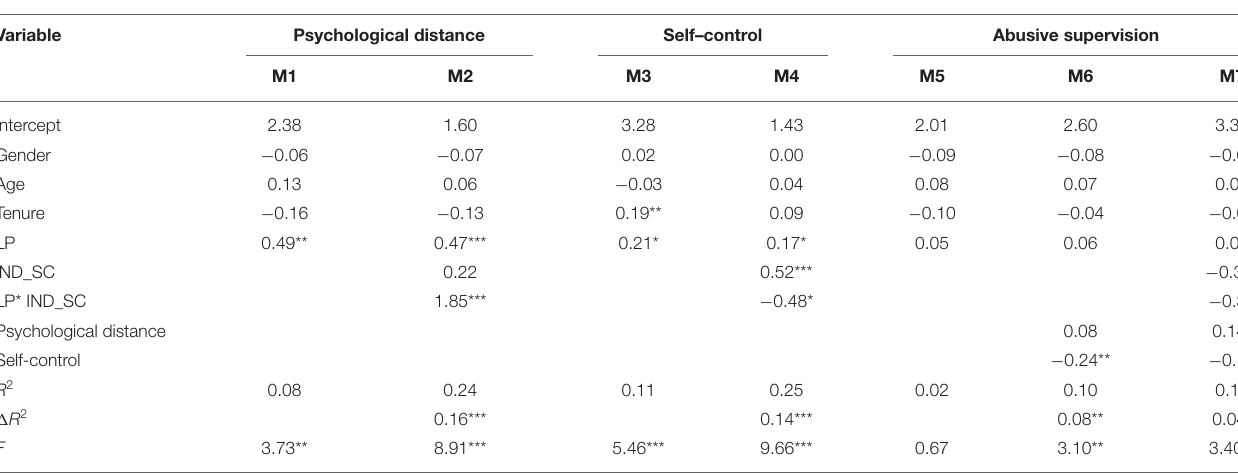
TABLE 4 | Regression results of Study 2.